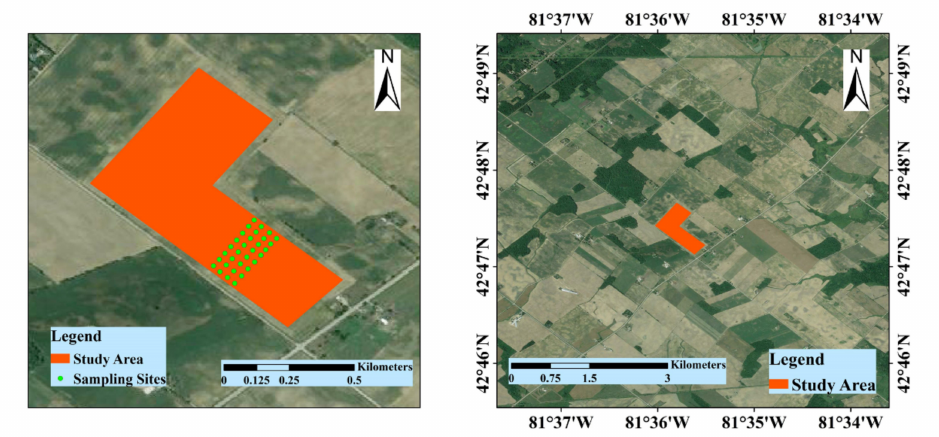
Figure 1. Location of the study